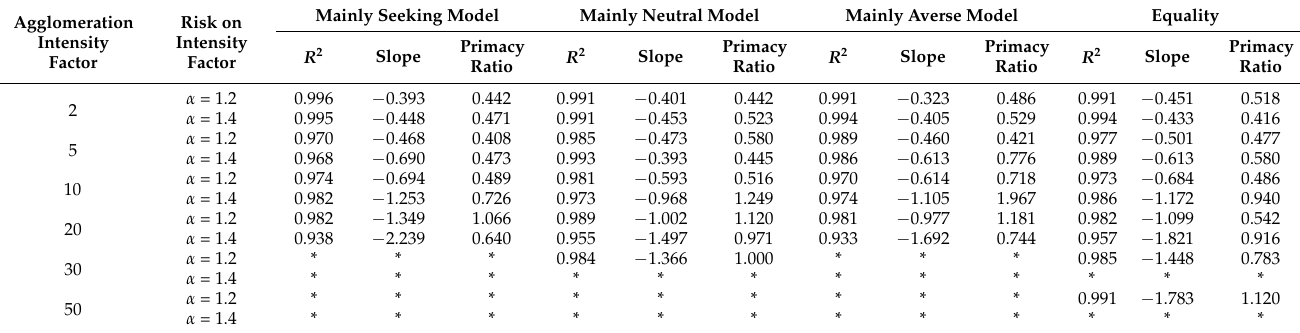
Table 5. Simulation results of multi-attitude